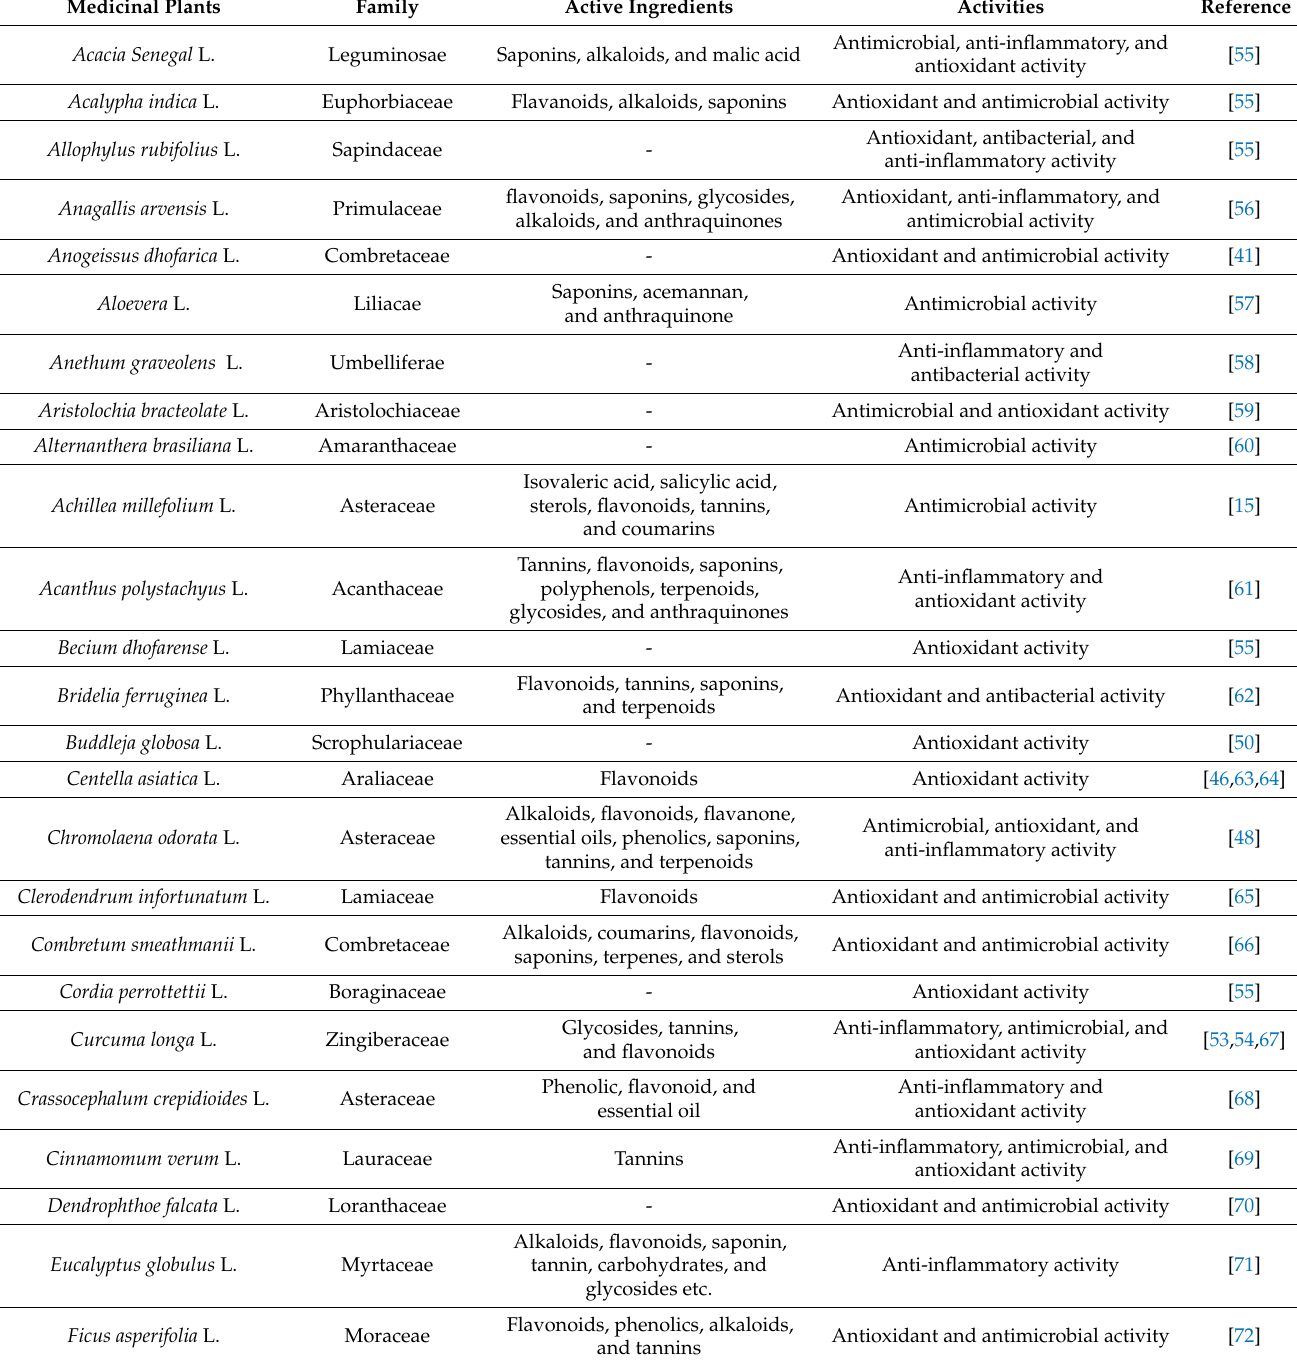
Table 1. Phytochemicals having antibiotic, antimicrobial, and antioxidants activity on wound healing. Medicinal